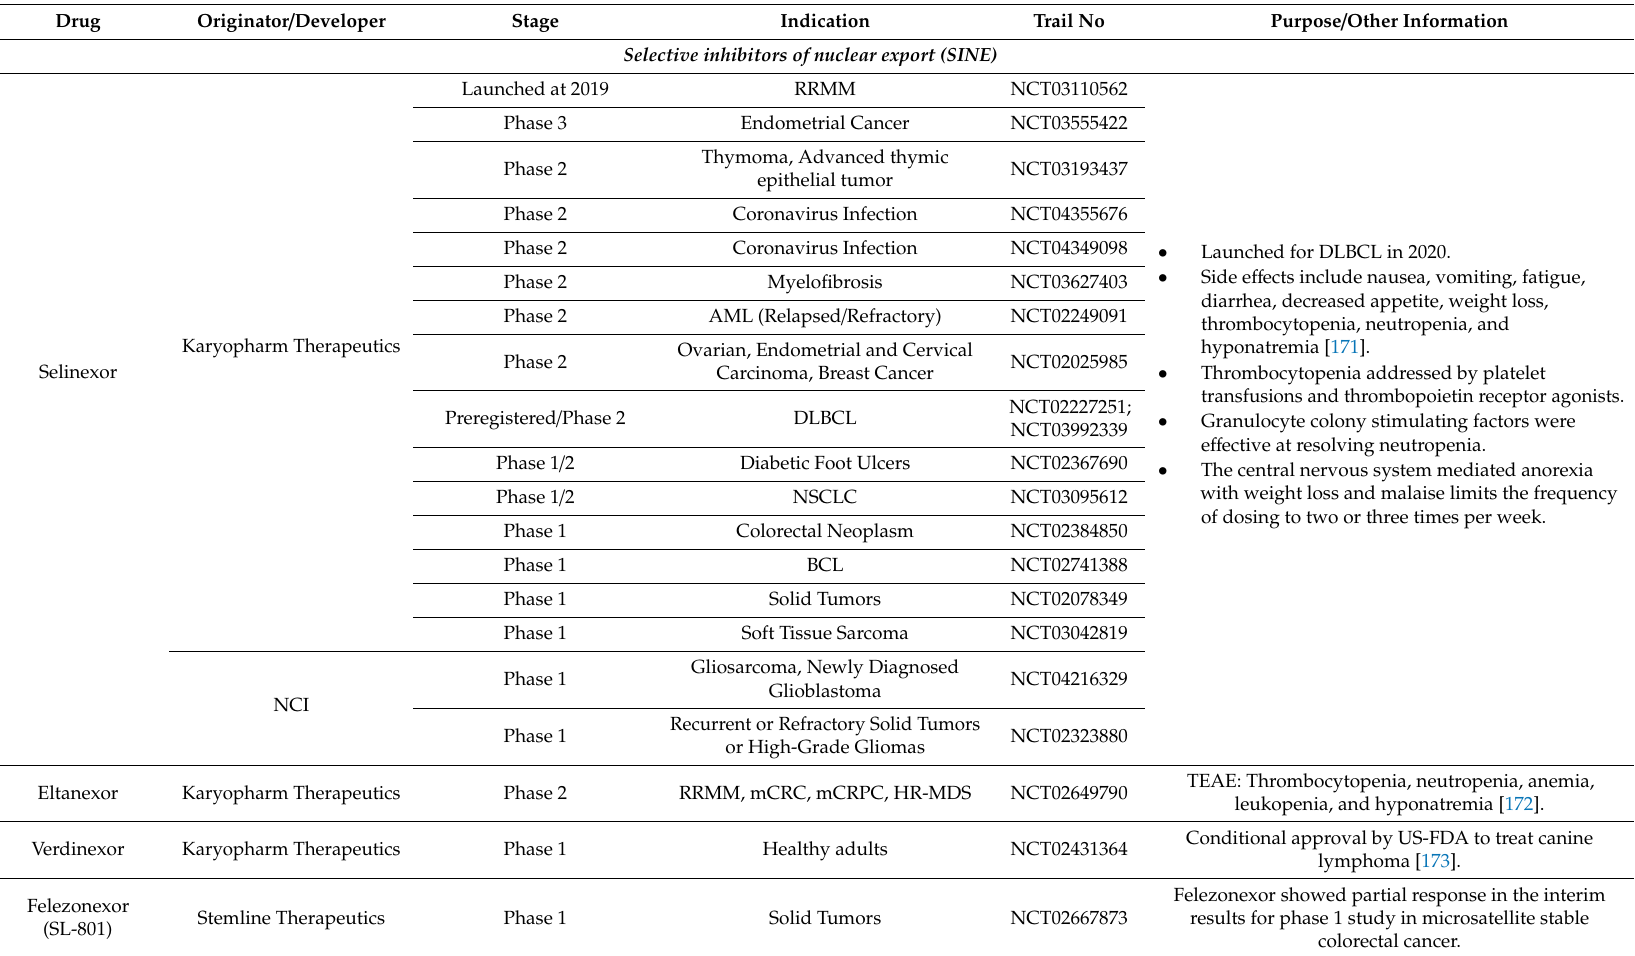
Table 5. Clinical small molecules inhibitors targeting nuclear translocation, DNA binding, and transcriptional activation of